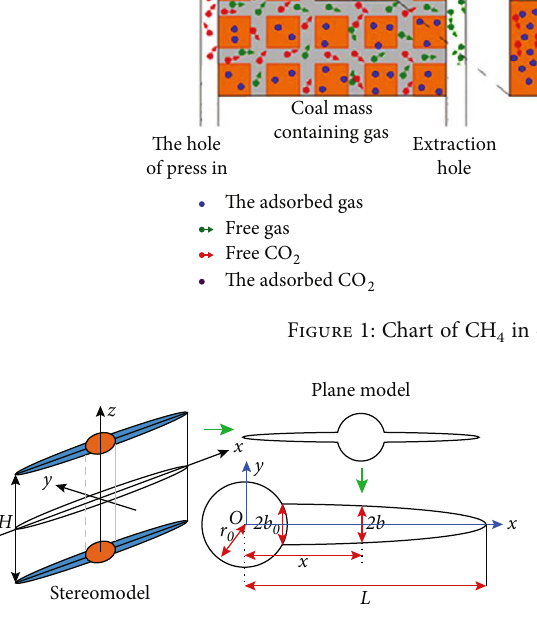
Figure 2: Diagram of crack